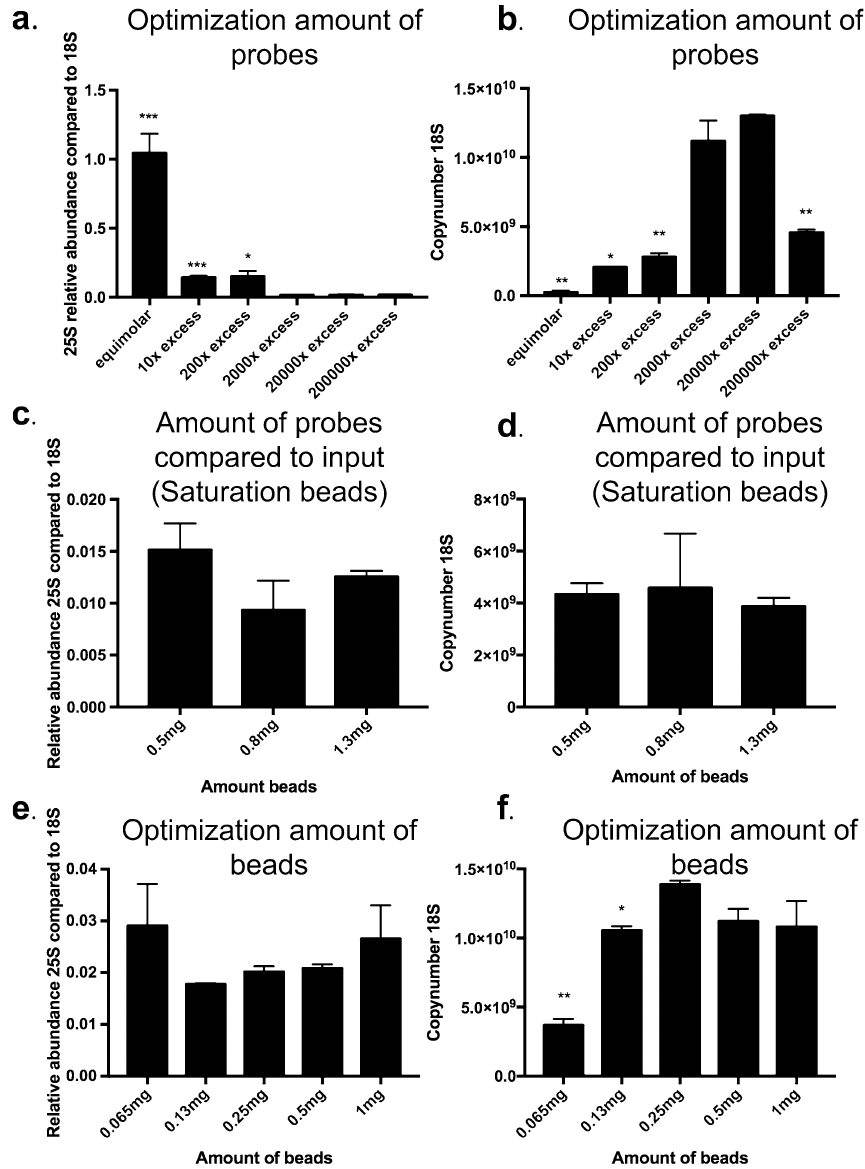
Figure 7. Determining amount of probes and beads required. *** represents a two-tailed p-value < 0.001, ** a two-tailed p-value < 0.01, * a two-tailed p-value < 0.05 ( a ) Relative abundance of 25S compared to 18S for different amount of probes (input 1.5 × 10 9 and 0.5 mg beads). Values are calculated as the amount of 25S after capture divided by the amount of 18S after capture. Error bars represent SEM, n = 2. ( b ) Yield after capture for a different amount of probes. (input 1.5 × 10 9 and 0.5 mg beads). Values are calculated by extrapolation on a standard curve of the plasmid PGEM-T_fulllength18S. Error bars represent SEM, n = 2. ( a,b ) Significance is determined with an unpaired t-test compared to 2,000 × excess. ( c ) Relative abundance of 25S compared to 18S for different amount of beads (input 1.5 × 10 9 and 200,000 × excess probes) Values are calculated as the amount of 25S after capture divided by the amount of 18S after capture. Error bars represent SEM, n = 2. ( d ) Yield after capture for different amount of beads (input 1.5 × 10 9 and 200,000 × excess probes). Values are calculated by extrapolation on a standard curve of the plasmid PGEM-T_fulllength18S. Error bars represent SEM, n = 2. ( c,d ) Significance is determined with an unpaired t-test compared to 0.5 mg. ( e ) Relative abundance of 25S compared to 18S for different amount of beads (input 1.5 × 10 9 and 2000 × excess probes). Values are calculated as the amount of 25S after capture divided by the amount of 18S after capture. Error bars represent SEM, n = 2. ( f ) Yield after capture for different amount of beads (input 1.5 × 10 9 and 2000 × excess probes). Values are calculated by extrapolation on a standard curve of the plasmid PGEM-T_fulllength18S. Error bars represent SEM, n = 2. ( e,f ) Significance is determined with an unpaired t-test compared 0.25